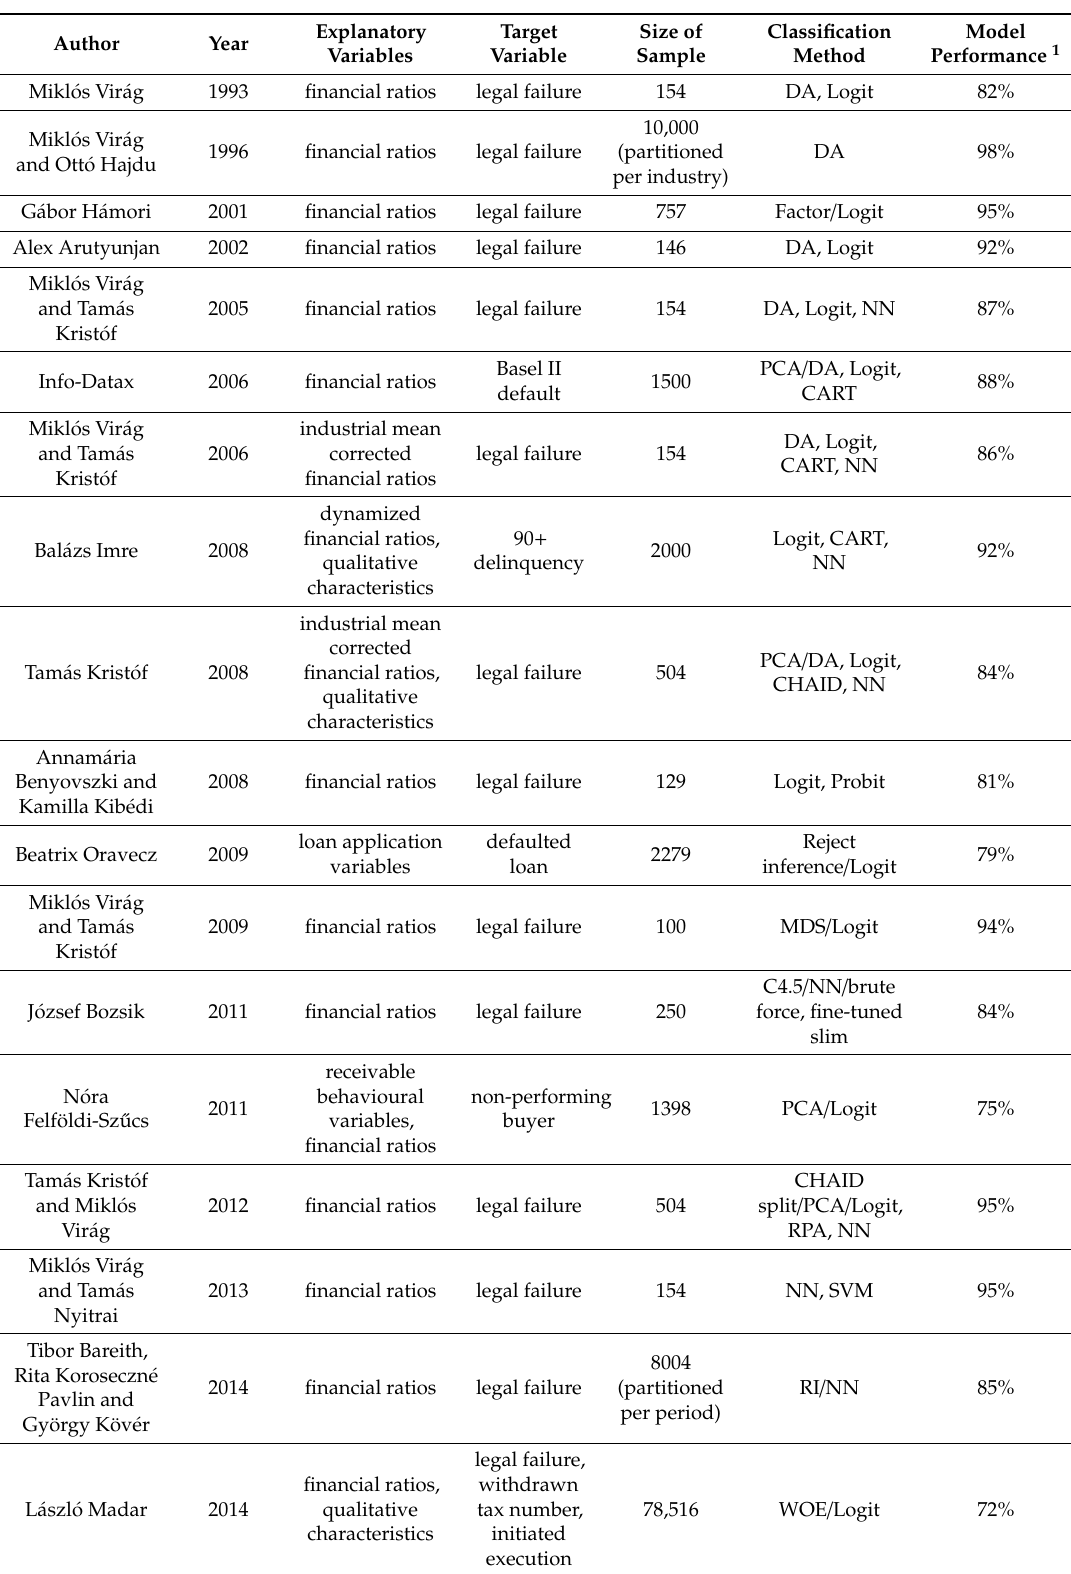
Table 1. Summary of Hungarian empirical corporate bankruptcy